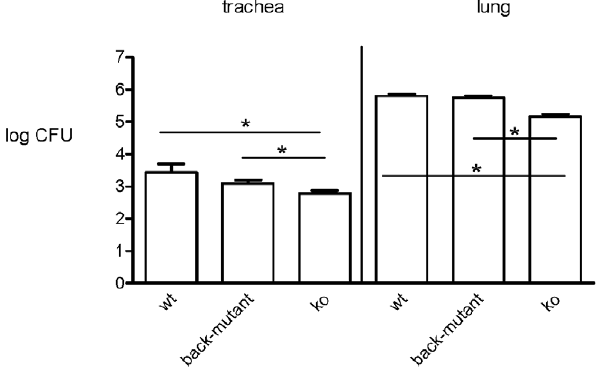
Figure 2. Role of Prn in colonization of the mouse respiratory tract. Mice were infected intranasally with the Tohama I strain (wt), a mutant derivative in which the Prn was inactivated (ko), or a back- mutant in which the Prn gene was restored. Three days post-infection, CFUs were determined in trachea and lungs. The experiment was performed twice, and pooled data from both experiments are shown. Error bars and asterisks indicate 95% confidence intervals and significant differences (P , 0.01), respectively.